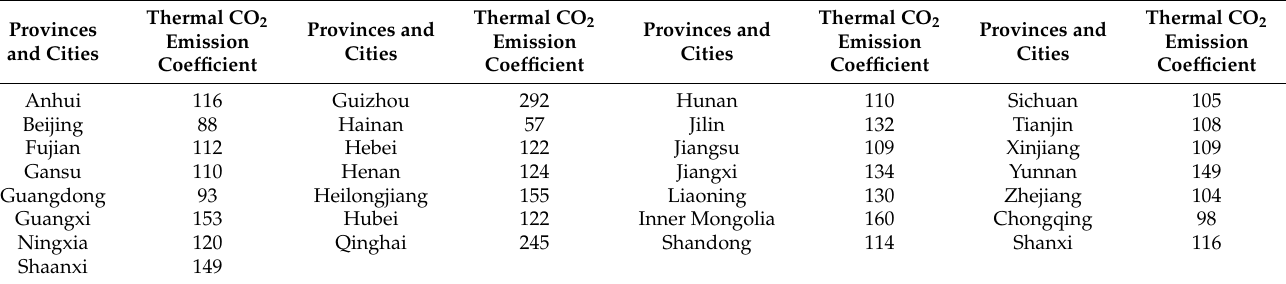
Table 5. Coefficient Thermal CO 2 emission (tCO 2 /MWh).